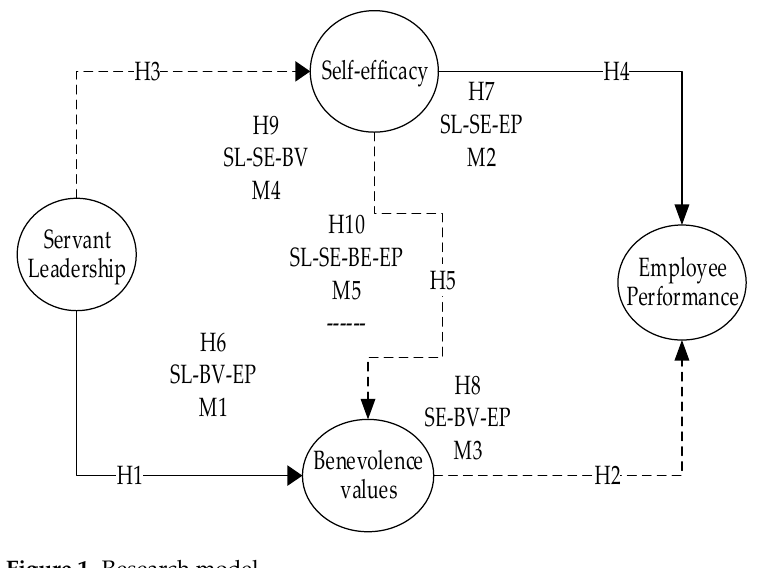
Figure 1. Research model.